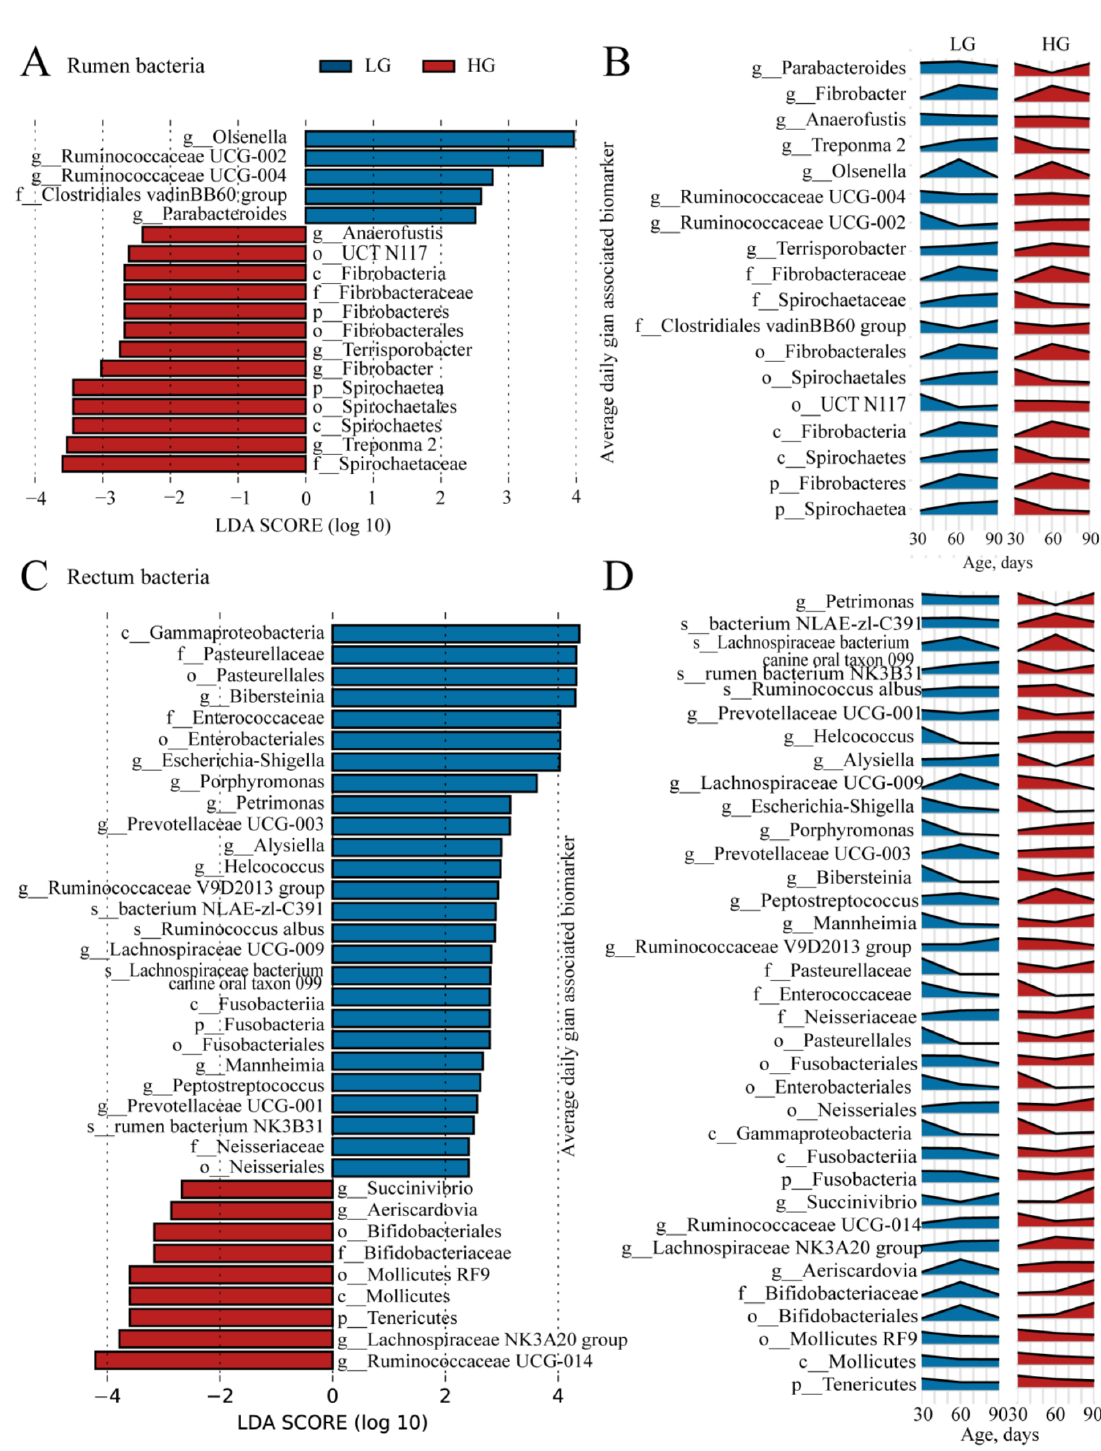
Figure 6. The identified bacterial biomarkers in the rumen and rectum of lambs are between the five lambs with the lower average daily gain (LG) and the five lambs with the higher average daily gain (HG). ( A ) The identified bacterial biomarkers in ruminal samples of lambs between the LG and HG groups using LEfSe analysis (LDA score > 2 and p < 0.05). ( B ) The changes over age show the relative abundances of the identified bacterial biomarkers in the rumen. ( C ) The identified bacterial biomarkers in rectal samples of lambs between the LG and HG groups using LefSe analysis (LDA score > 2 and p < 0.05). ( D ) The changes over age show the relative abundances of the identified bacterial biomarkers in the